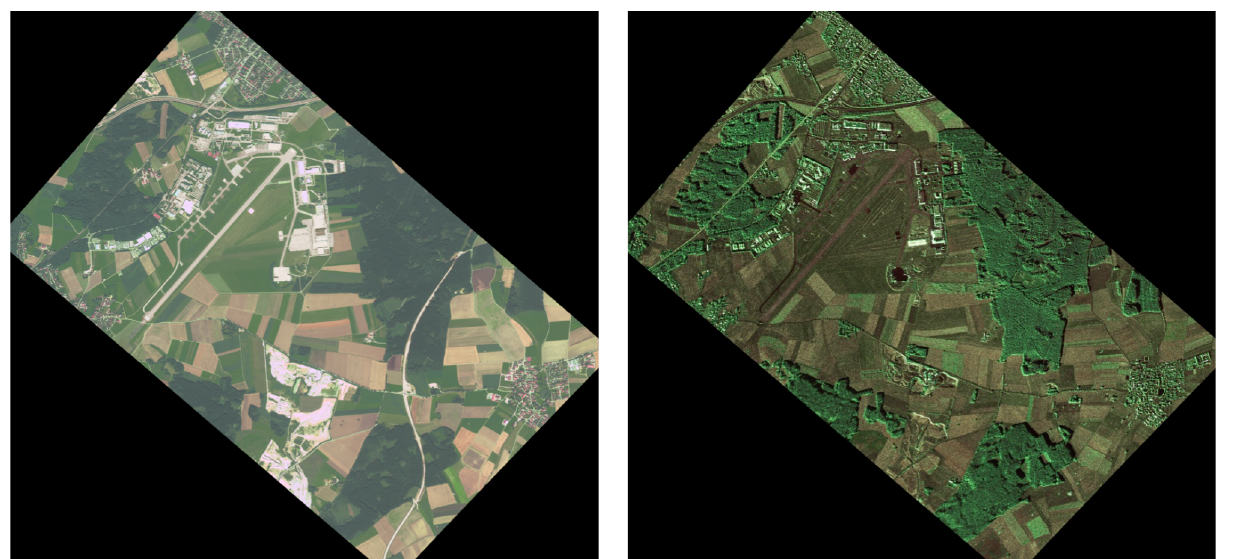
Figure 7. Sample X-band SAR image Figure 8. Sample L-band SAR image